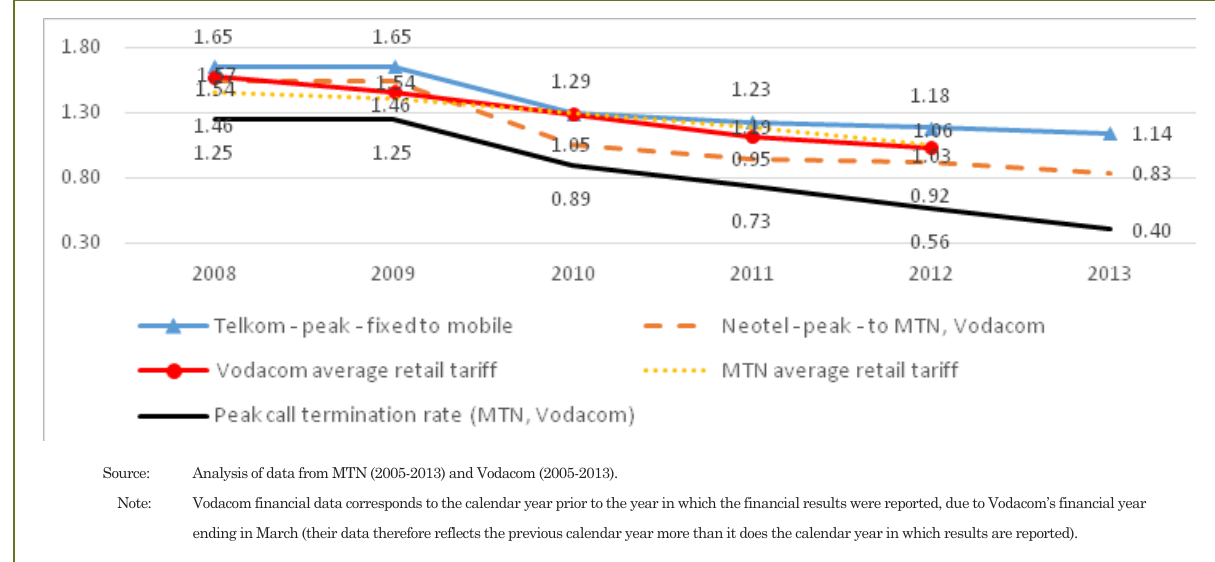
FIGURE 1: MOBILE CALL TERMINATION RATES (PEAK), AVERAGE MOBILE RETAIL PRICES AND PEAK FIXED TO MOBILE PRICES (ZAR / MINUTE)